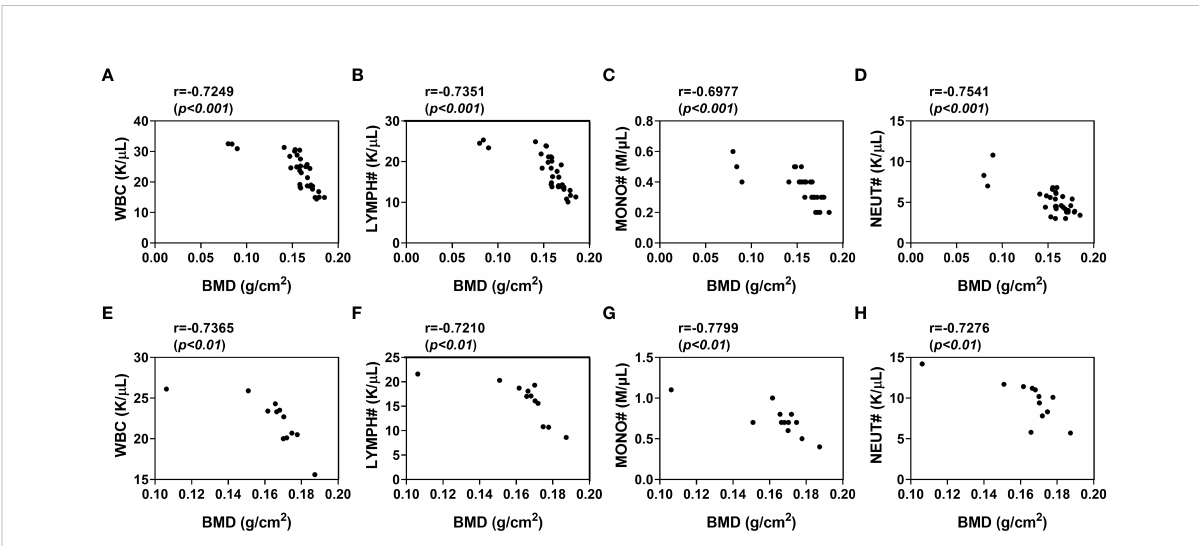
FIGURE 4 Correlation of WBC, lymphocytes, monocytes, neutrophils levels with BMD in osteoporotic mice after 8 weeks of osteoporotic mouse model construction. (A – D) Analysis of the correlation between WBC (A) , LYMPH# (B) , MONO# (C) , NEUT# (D) and BMD in estrogen de fi ciency-related osteoporotic mice (E, F) Analysis of the correlation between WBC (E) , LYMPH# (F) , MONO# (G) , NEUT# (H) and BMD in iron overload-induced osteoporotic mice. Sham, sham operation group; OVX, ovariectomy operation group; CTL, control group; OP, overload-induced osteoporotic group. BMD, bone mineral density; WBC, white blood cells; LYMPH#, lymphocytes; MONO#, monocytes; NEUT#, neutrophils.